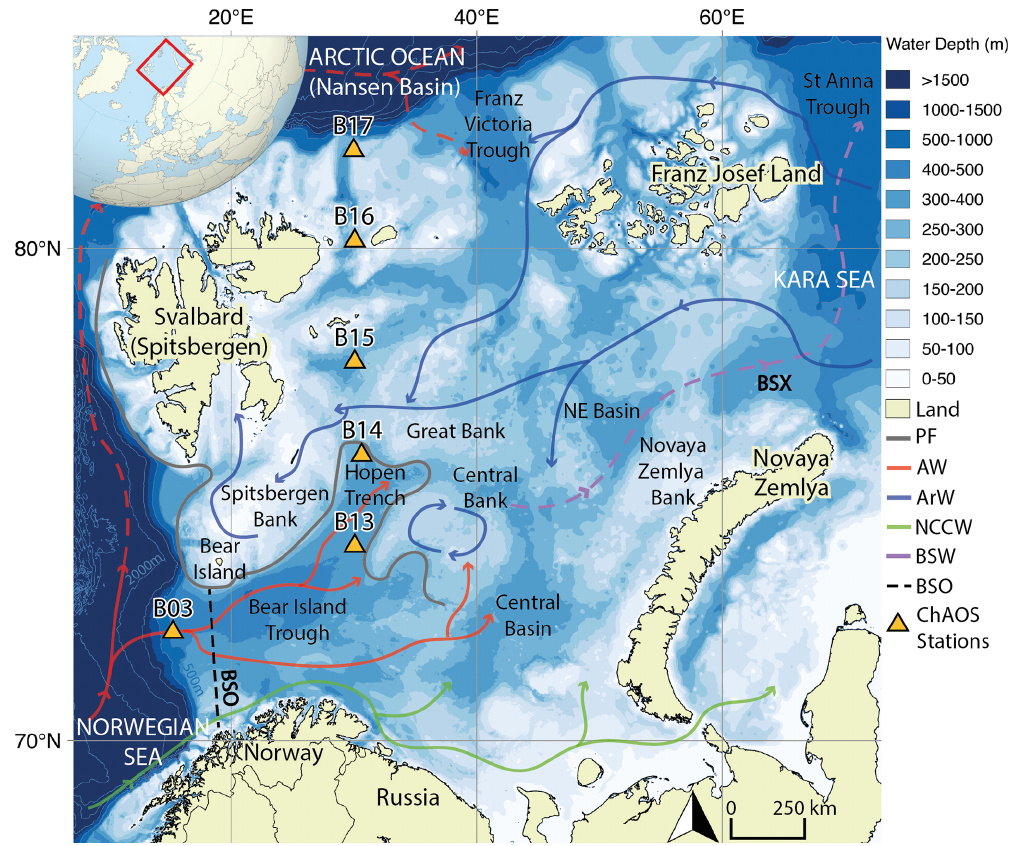
Figure 1. Map of the Barents Sea shelf, including ChAOS stations, the main hydrographic features and water masses from Ward et al. (2022) (PF – oceanic polar front, AW – Atlantic Water, ArW – Arctic Water, NCCW – Norwegian Coastal Current Water, BSW – Barents Sea Water, BSO – Barents Sea Opening, BSX – Barents Sea Exit). Dashed red path refers to a subsurface water mass (Lien et al., 2013). High-resolution bathymetry data taken from the General Bathymetric Chart of the Oceans (GEBCO) (Jakobsson et al.,